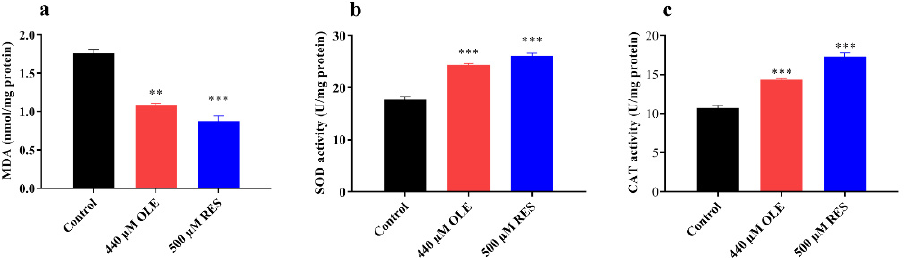
Figure 4. Effect of OLE on MDA content and antioxidant enzyme activities. ( a ) OLE reduced MDA contents; ( b ) OLE increased SODs activities; ( c ) OLE increased the CATs activities. ** p < 0.01 and *** p < 0.001 suggests significant difference when compared to control group.